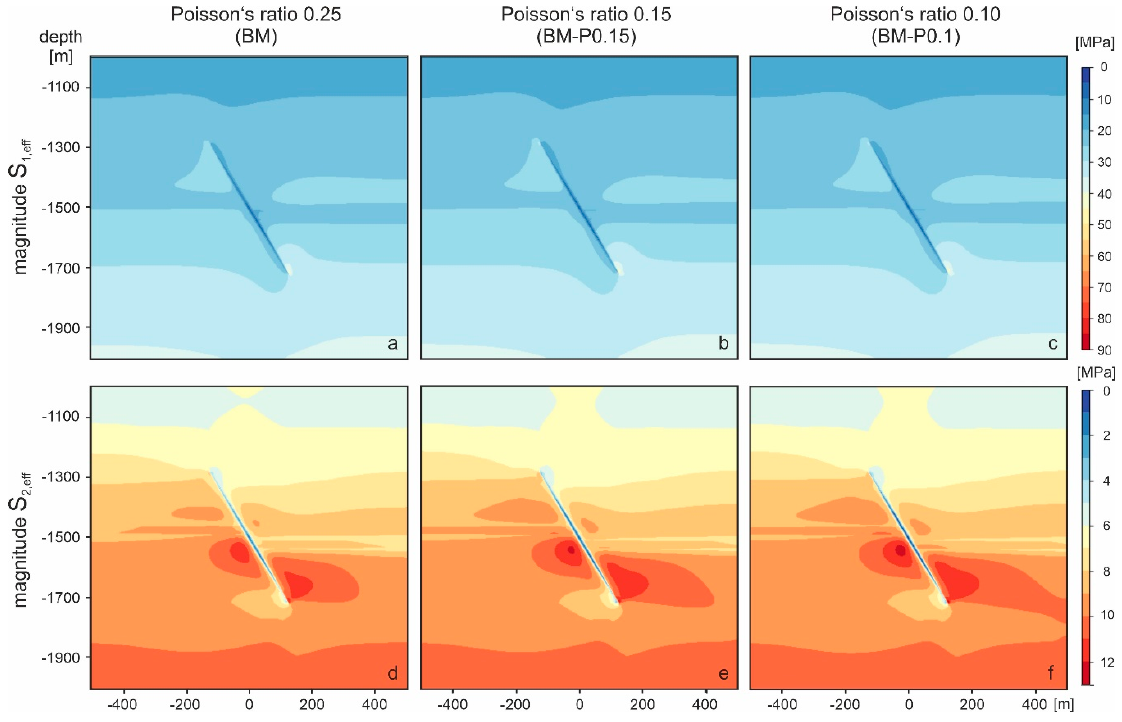
Figure 6. Spatial variations in the magnitude of S 1,eff ( a – c ) and the magnitude of S 2,eff ( d – f ) after five years of injection for three different Poisson’s ratios assigned to the fault zone.